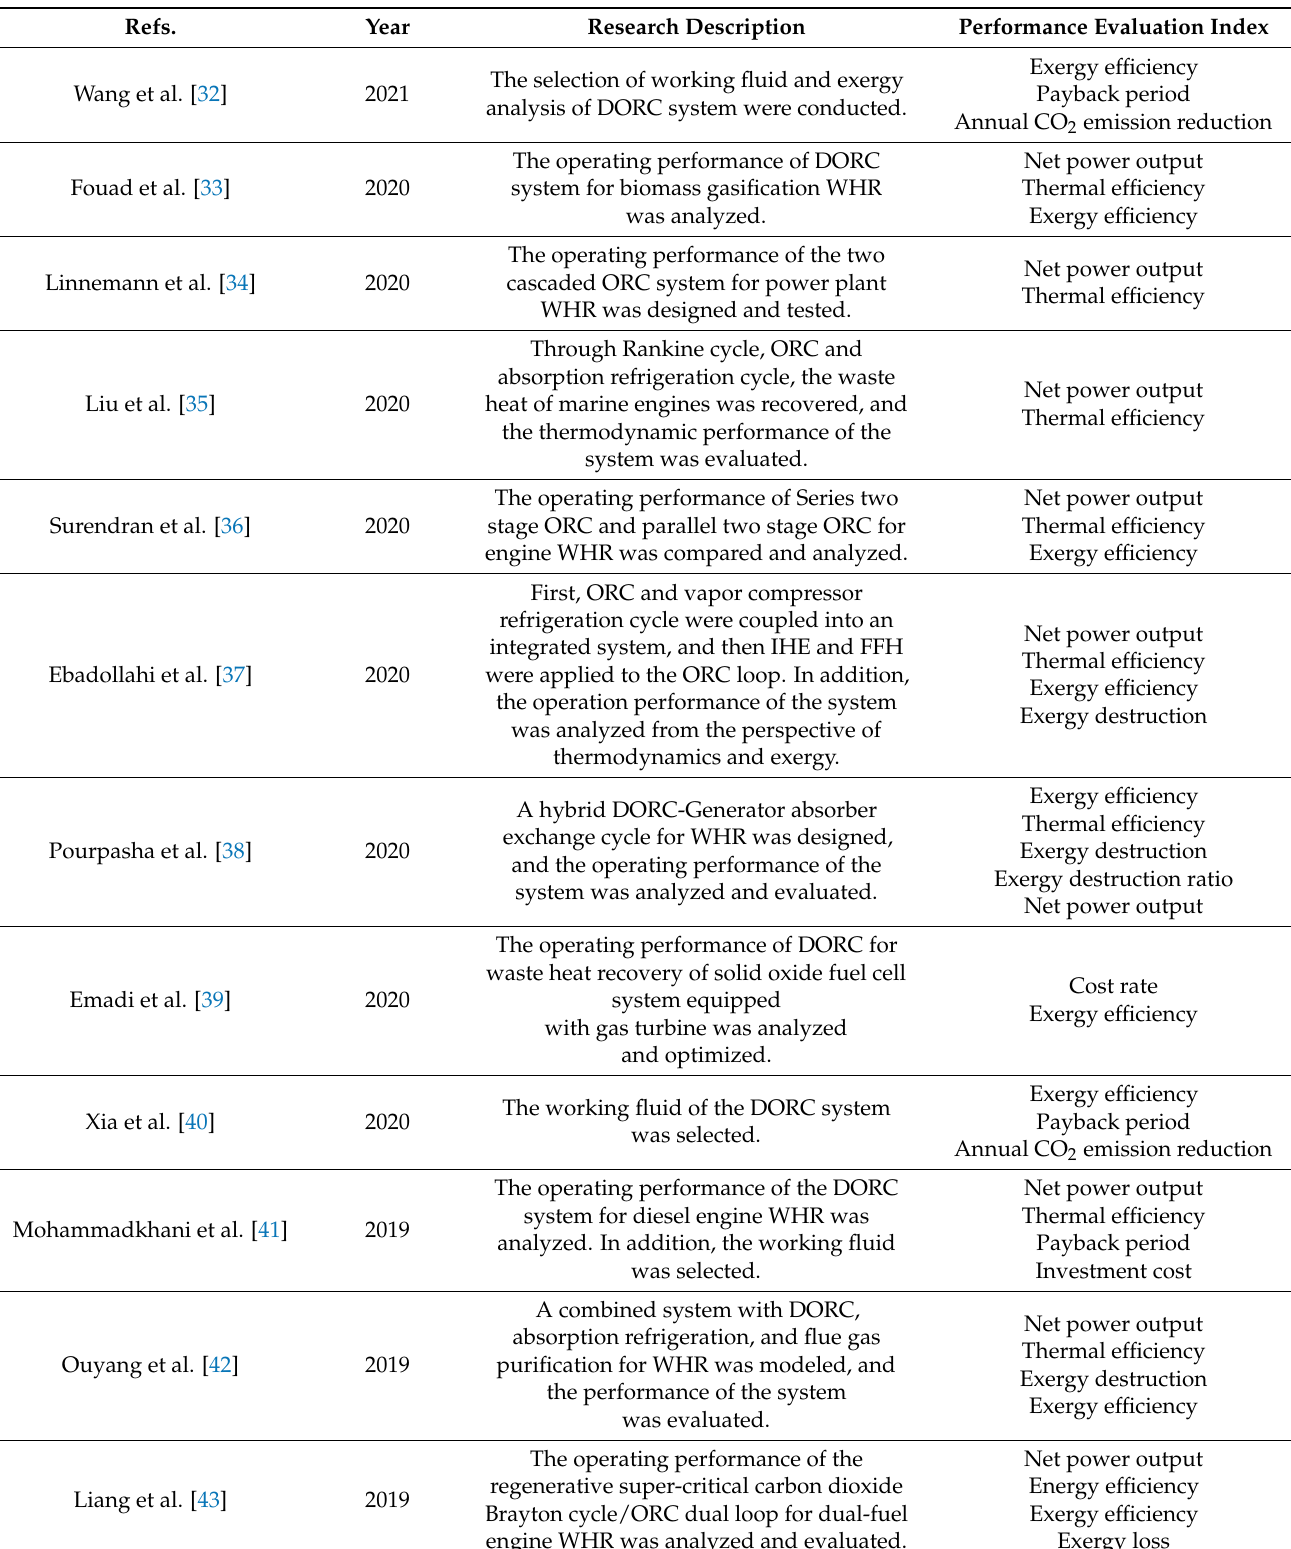
Table 2. Selection of ORC system operation performance index.